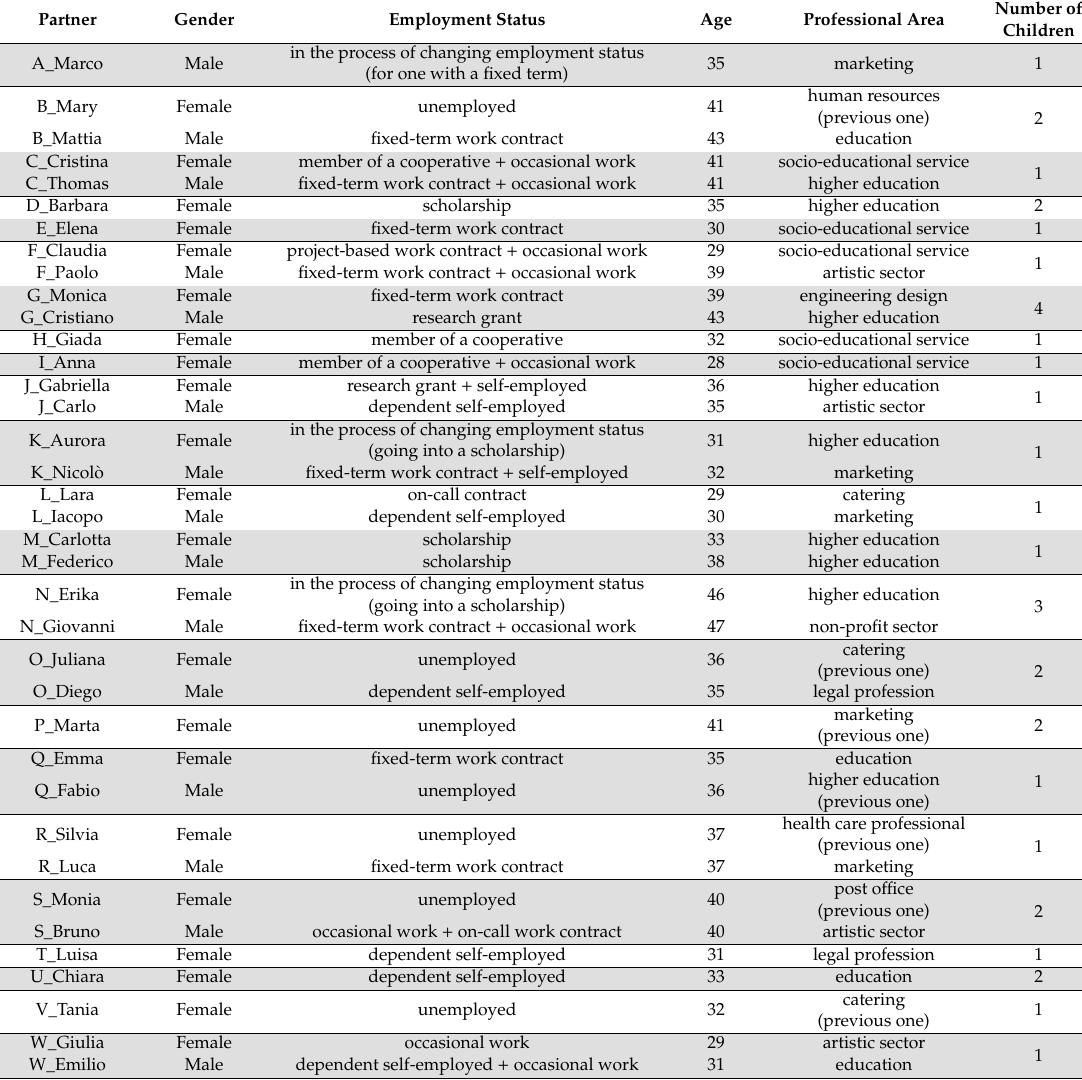
Table 1. Participants’